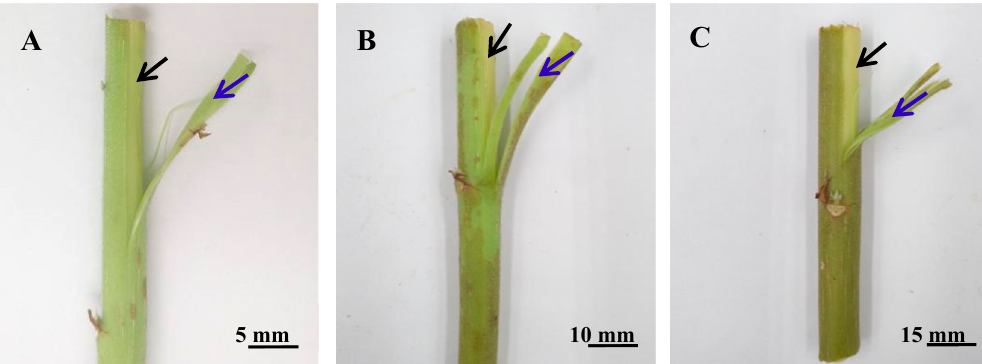
Figure 2. Morphology photographs of the xylem and phloem in ramie stems at three periods. ( A , B , and C ) Morphology photographs of xylem and phloem in ramie stems at the fast-growing period, maturation period, and late maturation period, respectively. Black arrow indicates the xylem section, and blue arrow indicates the phloem section. Table 2. Lignin content in the xylem and phloem of ramie stems at three periods (OD·g − 1 DW). Tissue